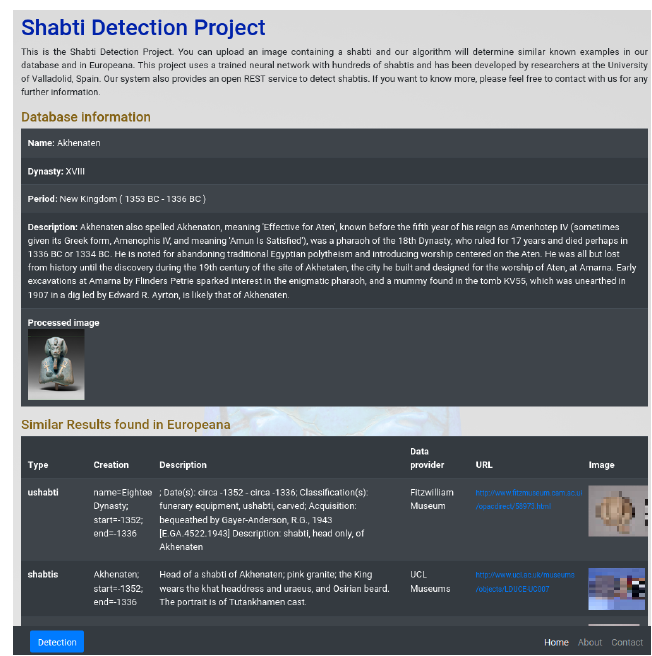
Figure 14. Web application integrating the full process: FN+HN detection and integration with Europeana. Shabti of Akhenaten (1353–1336 BC) at MET (Metropolitan Museum of Art), New